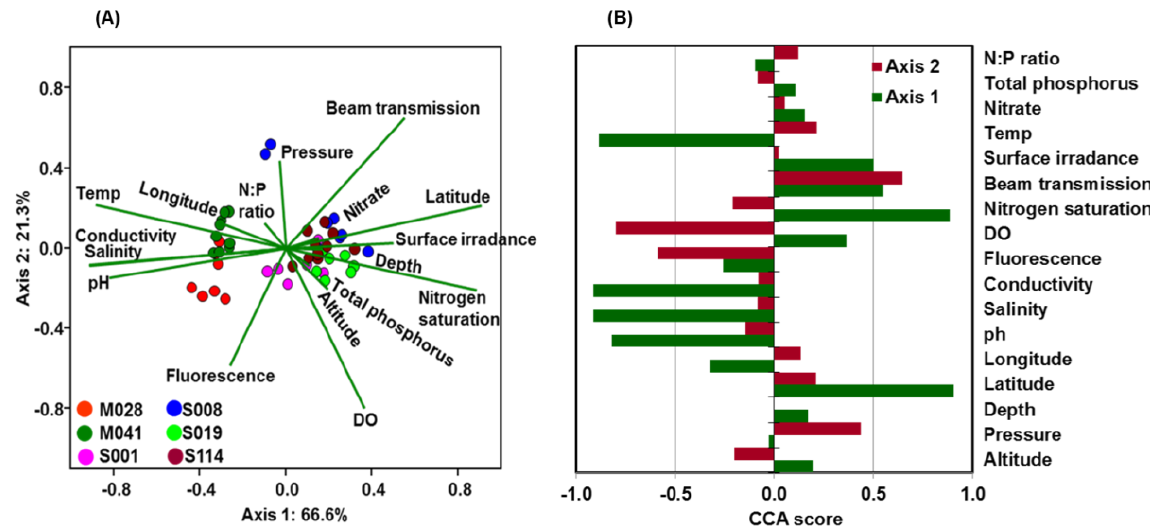
Figure 8. Canonical correspondence analysis (CCA) of ( A ) the environmental variables and microbial community at various depths across the lakes. Also shown is ( B ) a biplot of loading scores of environmental variables on each axis. Lines indicate direction and magnitude of measurable variables associated with community structure (loadings on each principal component). The percentage of total variance explained by each axis is noted in both the axis labels. Each symbol is color coded to represent lake or sampling locations and is provided in the figure description. Each color point represents a different bacterial community structure from each lake sample, and similar direction and magnitude of lines indicate a large positive association.